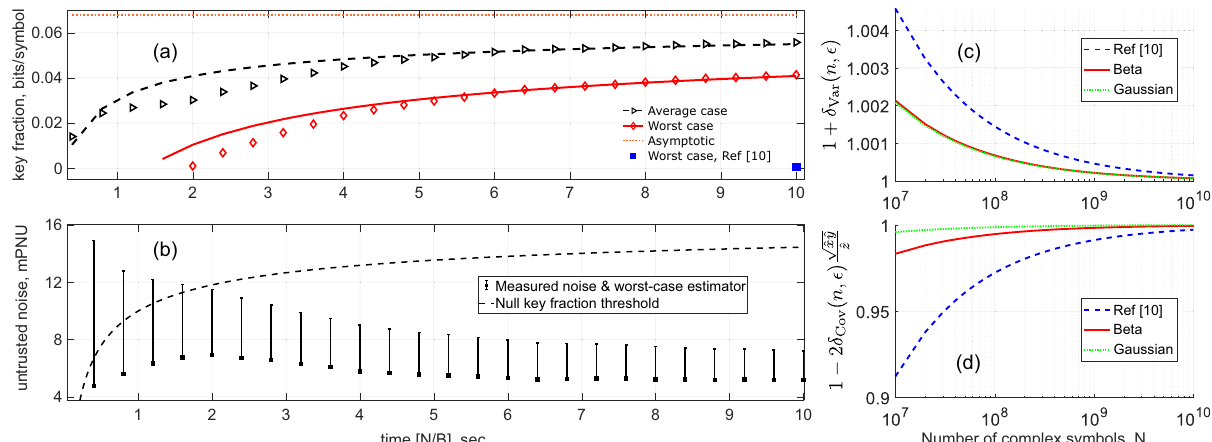
deviation of the simulation traces in ( a ) from the experimental data between 1 and 5s is due to the slight increase in ξ u . c , d Comparison of con fi dence intervals derived in this manuscript (Beta; solid-red trace and Gaussian; dotted-green trace) with those derived in the original composable security proof (ref. 10;